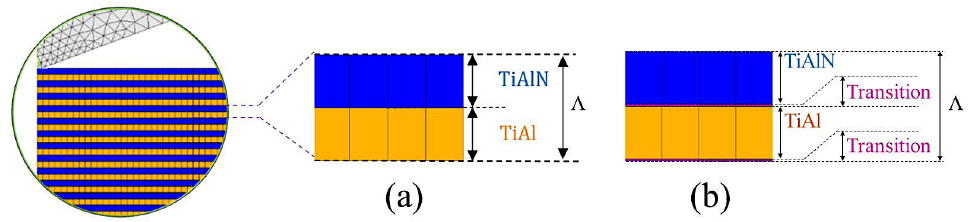
Figure 3. Modelling of multilayer films, (a) with perfect interfaces (b) with a transition layer.